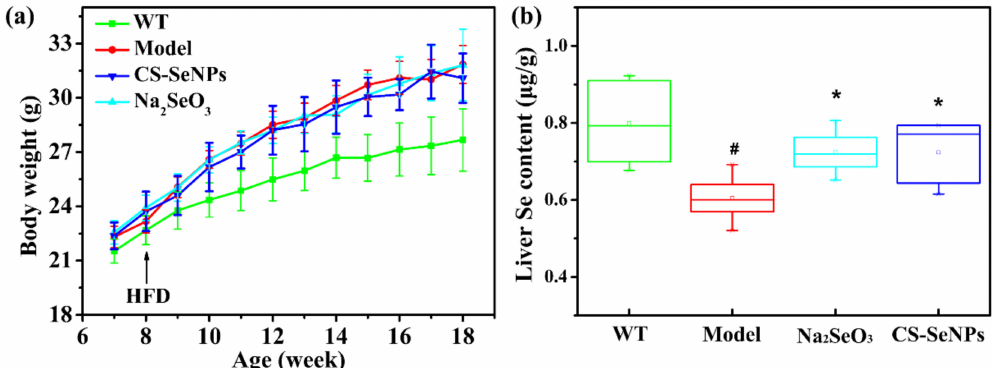
Figure 2. Effect of CS-SeNPs and Na 2 SeO 3 on ( a ) body weight ( n = 10) and ( b ) liver Se content ( n = 6) in ApoE -/- mice. The results were expressed as mean ± SD. # p < 0.05, compared with the WT group. * p < 0.05, compared with the AS model